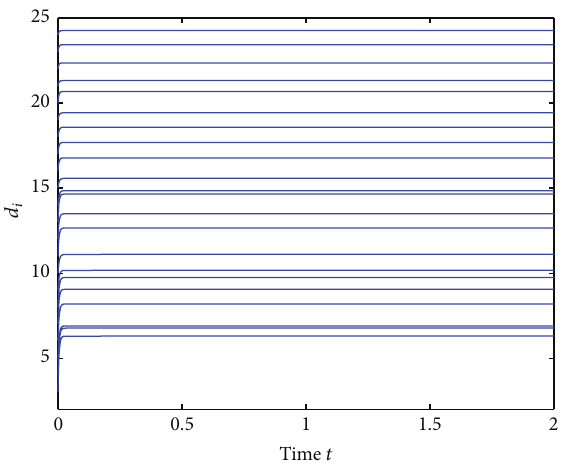
Figure 4: Evolution of adaptive feedback gains 𝑑 𝑖 with 1 ≤ 𝑖 ≤ 15 .